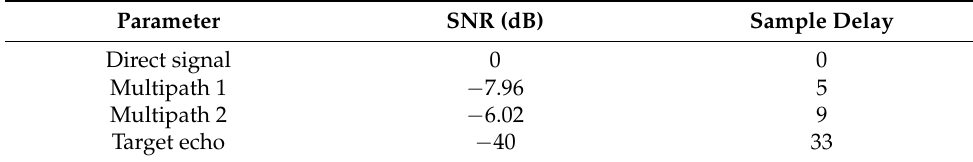
Table 2. Related simulation